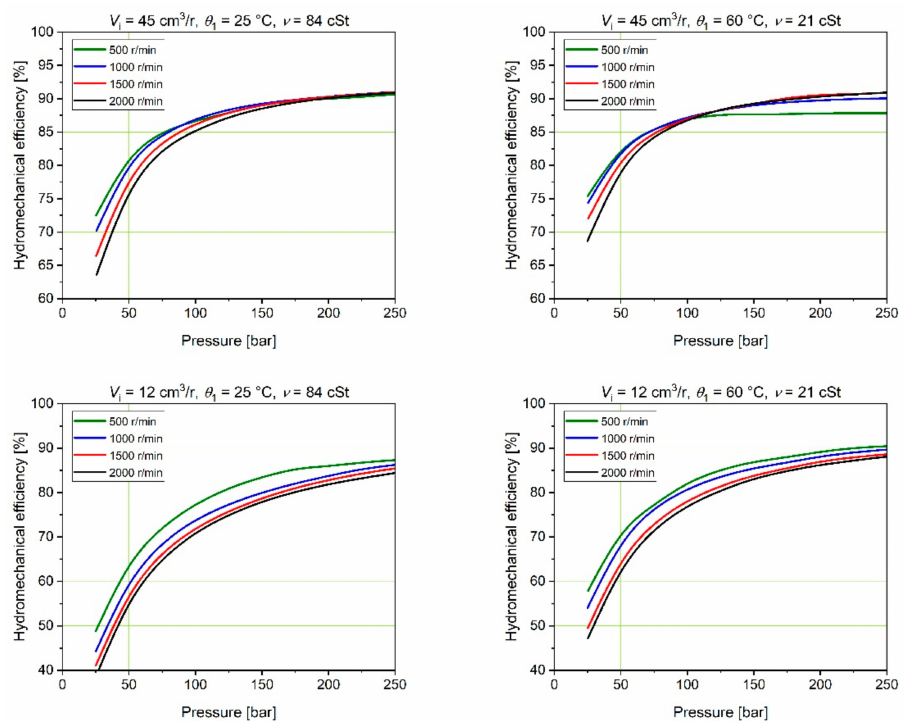
Figure 9. Hydromechanical efficiency of an axial piston pump as a function of pressure with four constant rotational speeds. The ten-calculation-point efficiency curves have been smoothed with B-splines. Note the varying efficiency